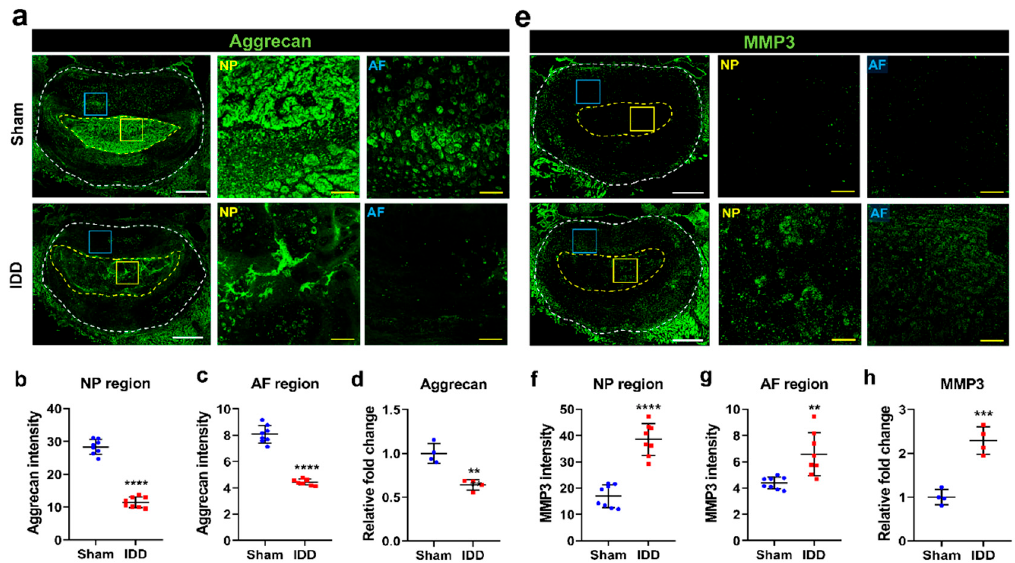
Figure 3. Intervertebral disc degeneration in IDD model. ( a ) Representative immunohistochemical low and high images of aggrecan expression (green) in the NP and AF regions of the sham and IDD groups. White scale bar = 1000 µm, Yellow scale bar = 100 µm; ( b , c ) Relative intensity of aggrecan expression in the NP and AF regions of the sham and IDD groups (n = 10/group); ( d ) Relative fold change of aggrecan mRNA levels in the sham and IDD groups (n = 4/group); ( e ) Representative immunohistochemical low and high images for MMP3 expression (green) in the NP and AF regions of the sham and IDD groups. White scale bar = 1000 µm, Yellow scale bar = 100 µm; ( f , g ) Relative intensity of MMP3 expression in the NP and AF regions of the sham and IDD groups (n = 10/group); ( h ) Relative fold change of MMP3 mRNA levels in the sham and IDD groups ( n = 4/group). Data are expressed as the mean ± SEM. Significant differences indicated as ** p < 0.01 *** p < 0.001, and **** p < 0.0001 vs. sham group were analyzed via unpaired t-tests with Welch’s correction. AF, annulus fibrosus; IDD, intervertebral disc degeneration; MMP3, metalloproteinase 3; NP, nucleus pulposus; SEM, standard error of the mean.